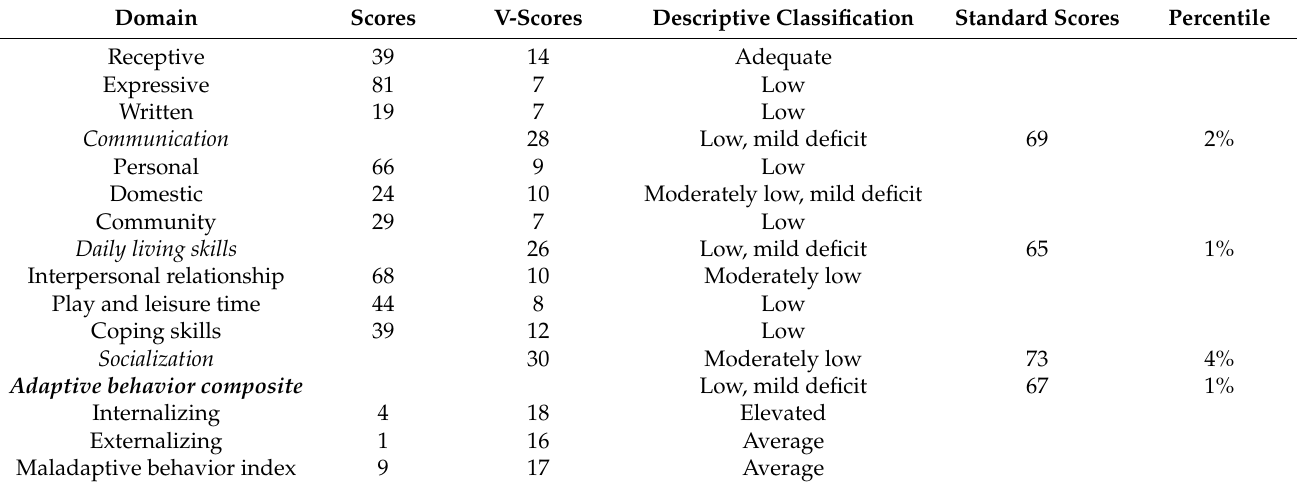
Table 3. Results of the Adaptive Functioning Assessment using